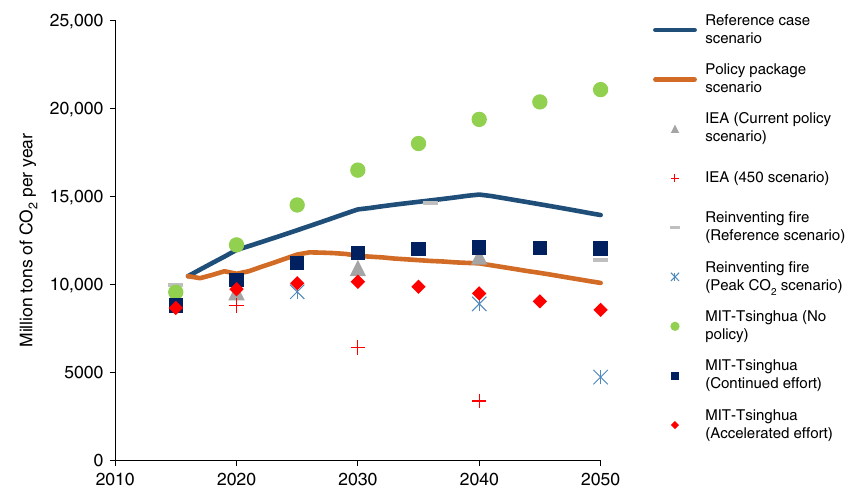
Fig. 4 Total CO 2 emissions in China under different scenarios. The results of the policy package scenario show China ’ s CO 2 emissions from energy combustion, industrial processes, and land use, land use change, and forestry (LULUCF) peak twice, which is different from previous predictions. The fi rst peak is a temporary, small peak in 2019 at the level of 10.7 billion tons. There is a subsequent permanent peak in 2026 at the level of 11.8 billion tons, well ahead of the 2030 target. After 2026, a long-lasting plateau ensues until 2040 rather than a decisive post-peak drop in emissions. Meanwhile, the CO 2 emission comparisons between the scenarios of our model and the scenarios of the other models 8,9,18 indicate the robustness of our model setting. The CO 2 emission level of our reference case scenario is between that of MIT-Tsinghua (No policy) and Reinventing Fire (Reference scenario). The CO 2 emission level of our policy package scenario is higher than the levels of MIT-Tsinghua (Continued effort) and IEA (Current policy) as we include more climate change policies, but higher than the levels of the Peak CO 2 scenario of Reinventing Fire, MIT-Tsinghua (Accelerated effort) and IEA (450 scenario) where new policies beyond current policy package are